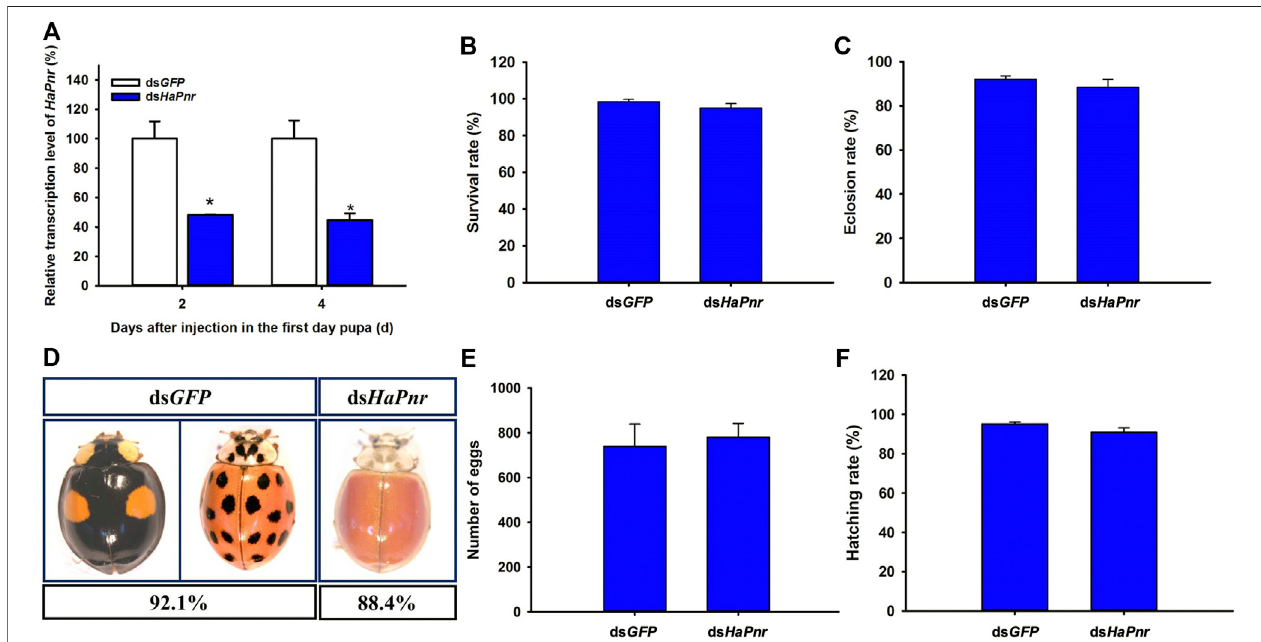
FIGURE5 | Suppression of HaPnr transcriptin theone-day-old pupa of H. axyridis injected with dsHaPnr and dsGFP at 300 ng/pupa as determined byRT-qPCR (A) . The survival rate (B) and eclosion rate (C) of the one-day-old pupae injected with dsHaPnr and dsGFP , respectively. The phenotype of adults after the one-day-old pupae were injected with dsHaPnr and dsGFP , respectively (D) . The cumulative egg number of three pairs of ladybirds within 15 days (E) and the hatching rate of eggs (F) .Theresultsarepresentedasthemeanandstandarderrorsofthreereplicates;eachwasperformedwithanRNAsamplepreparedfromthreeinsects.Asterisks above the standard error bars indicate signi fi cantly different (Duncan tests, p <